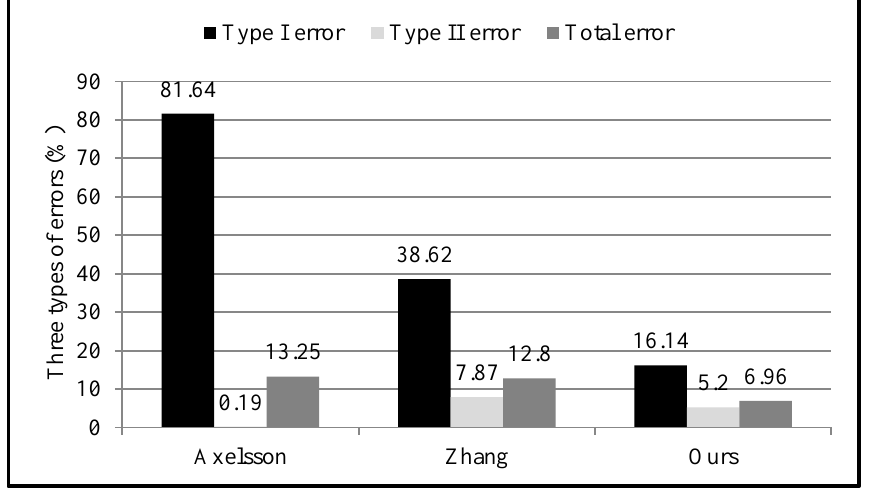
Figure 18. Three types of errors on data with high point density for PTDF, CSF, and our algorithm.